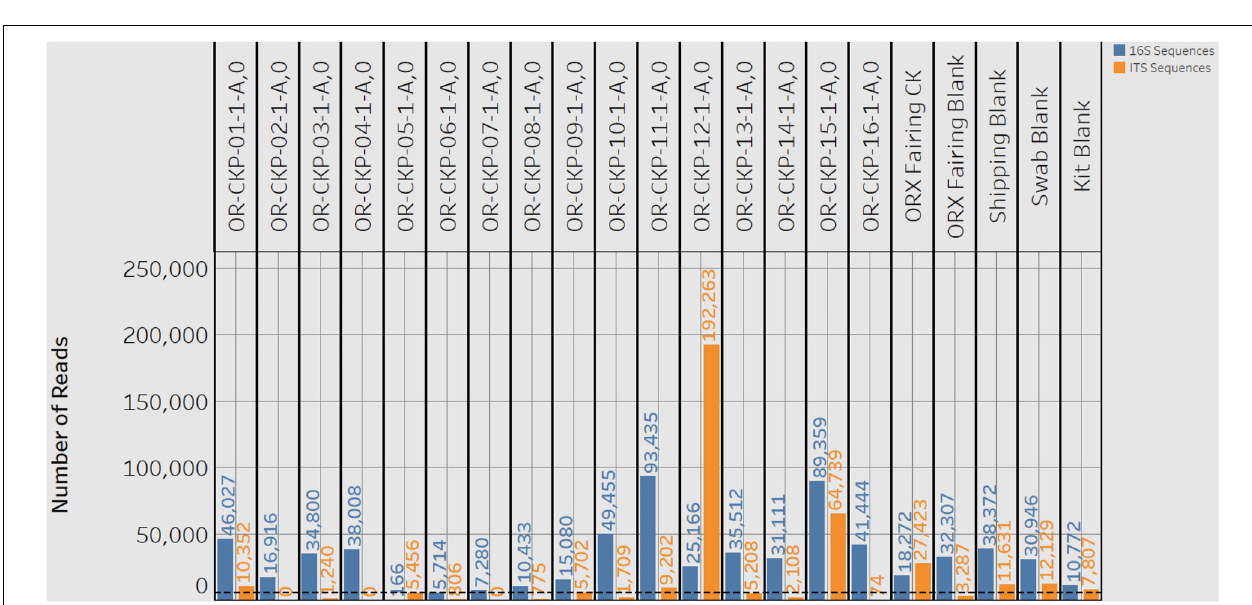
FIGURE 2 | A plot of the fraction of reads for each standard that mapped to the known organism Bacillus subtilis vs. the number of cells in each samples (A) and the fraction of reads for each standard that mapped to the known organism Bacillus subtilis vs. the number of reads or sequences collected for each sample (B) . The data was fit using an allosteric sigmoidal equation. The detection limit for this sequencing run was 7 ± 3 cells and 5,611 ± 3,369 reads.